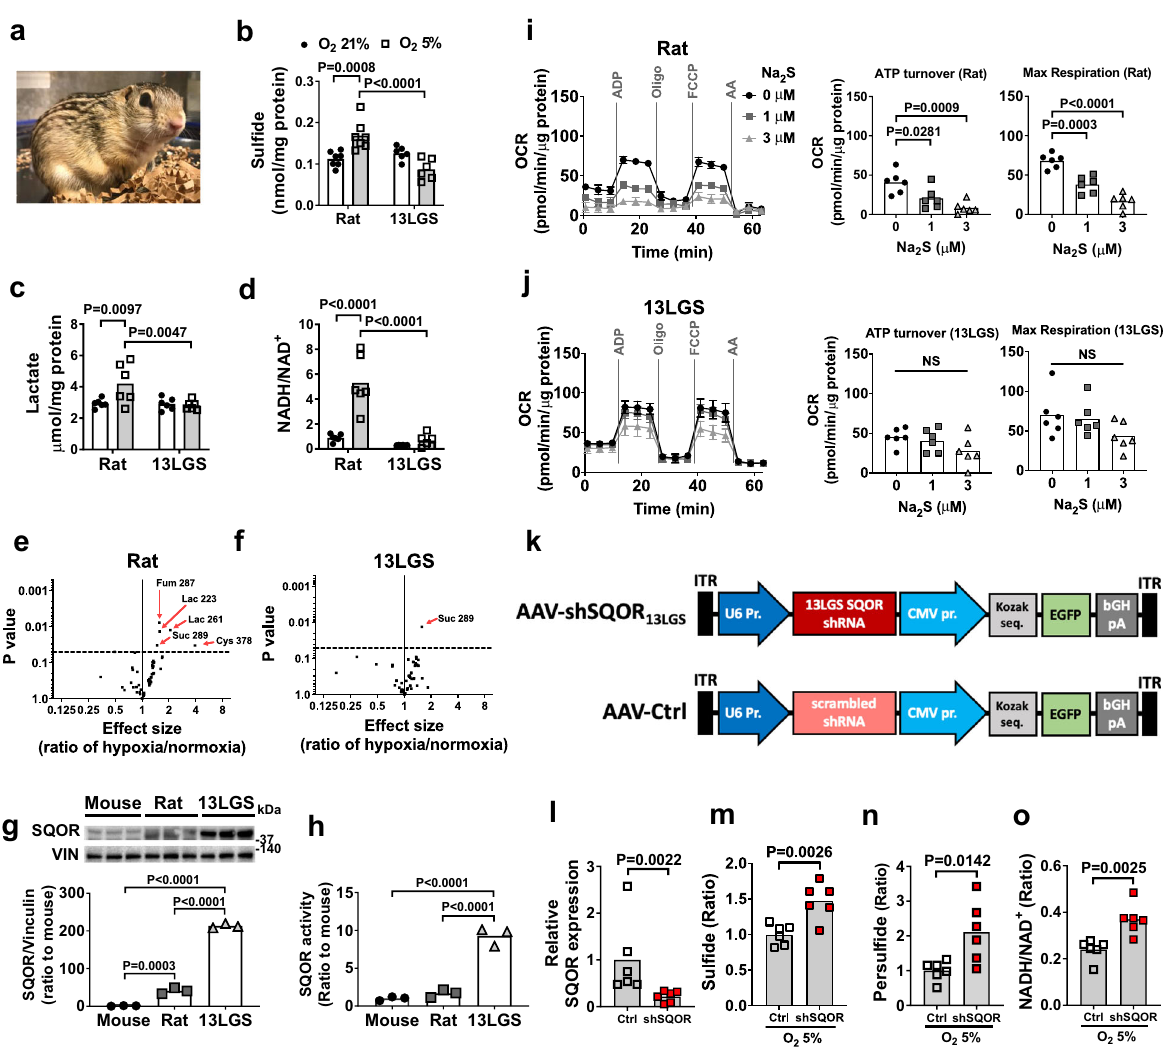
Fig. 4 Hypoxia tolerance and enhanced sul fi de catabolism in 13-lined ground squirrels. a 13 lined ground squirrel. Levels of b sul fi de ( n = 7, 7, 6, 6), c lactate ( n = 6 each), and d NADH/NAD + ratio ( n = 6 each) in brains of rats and 13LG squirrels (13 LGS) breathing 21% or 5% oxygen for 5 min under iso fl urane anesthesia. Volcano plots showing the changes in whole-brain metabolite pro fi les in response to breathing 5% oxygen in e rats and f 13LG squirrels. Lac, lactate; Cys, cysteine; Fum, fumarate; Suc, succinate. g Immunoblots and protein expression levels of SQOR in forebrains of mouse, rat, and 13LG squirrel ( N = 3 each). h SQOR enzyme activity in forebrains in mouse, rat, and 13LG squirrel ( N = 6 each). ATP turnover rate and maximal respiratory rate of isolated brain mitochondria measured as oxygen consumption rate (OCR) in i rats and j 13LG squirrels incubated with 0, 1, or 3 μ M of Na 2 S ( n = 6 each). k Structure of AAV containing shRNA against 13LG squirrel SQOR (AAV-shSQOR 13LGS ) under a U6 promoter for RNA polymerase III and control AAV (AAV-Ctrl) containing scrambled shRNA. l Relative SQOR mRNA levels in the brain of 13LG squirrels infected with AAV-Ctrl (Control) or AAV- shSQOR 13LGS (shSQOR). Relative levels of m sul fi de and n persul fi de and o the ratio of NADH/NAD + in the brains of Control or shSQOR-infected 13LG squirrels breathing 5% oxygen under anesthesia. n = 6 each. Data are presented as mean ± SEM or mean and individual values. Two-way or one-way ANOVA followed by Sidak ’ s correction for post-hoc comparisons were performed for b – d and g – j . Volcano plots were created using values in Supplementary Table S1 and S2. A two-tailed unpaired t -test was performed for l , n , and o . Mann – Whitney U test was performed for m